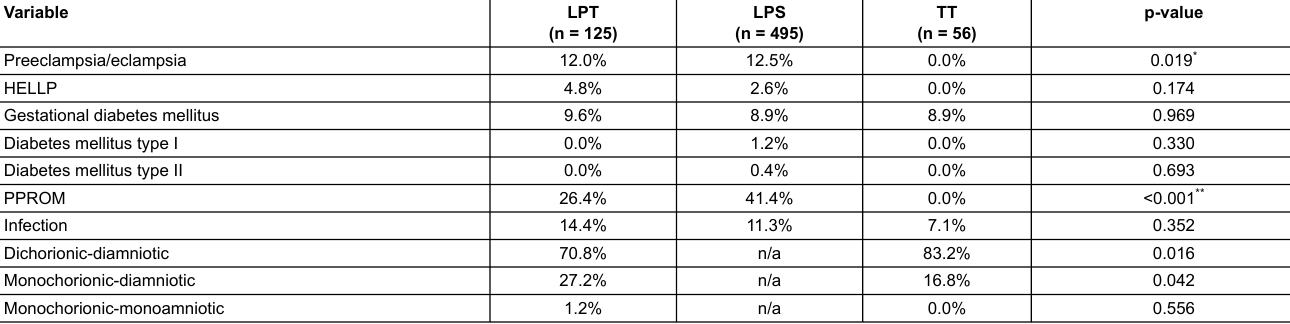
Table 3: Maternal characteristics for all three groups.